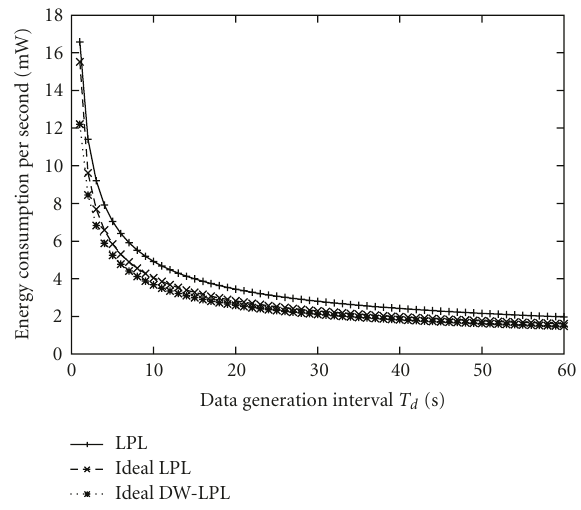
Figure 5: The energy consumption comparison for sporadic tra ffi c ( δ = 0 . 3 and T on = 0 .